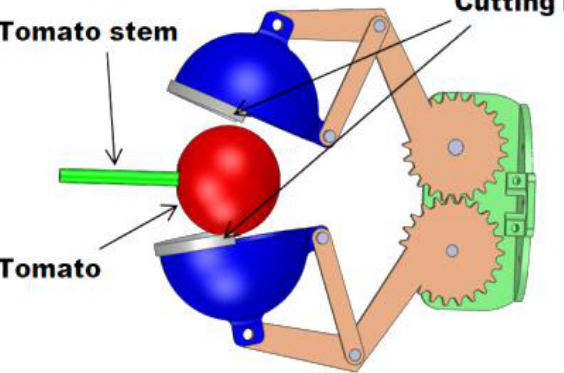
Figure 6. Gripper working process.